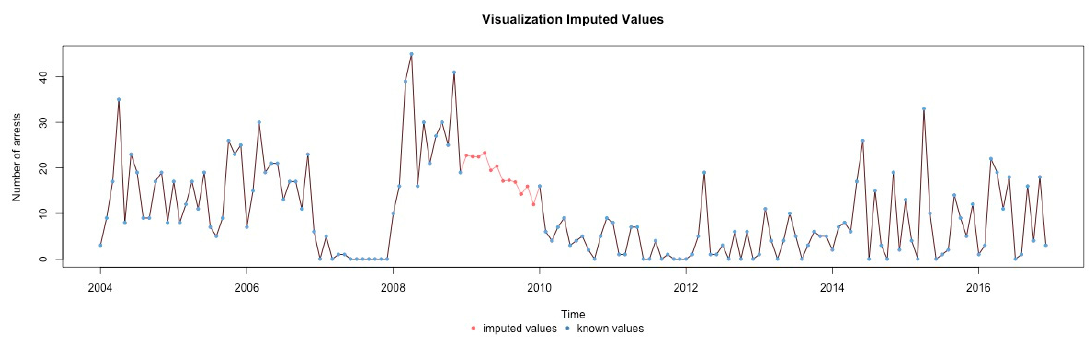
Figure A11. Methamphetamine-related organized crime arrests 2004–2016 in the Czech Republic – imputed missing values.